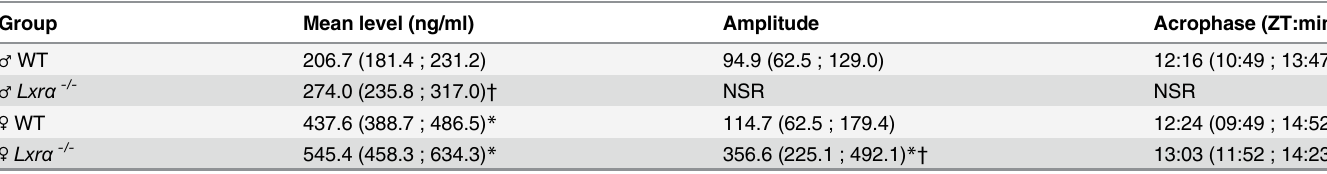
For each parameter measured, values are represented as median ± 95% bootstrap con fi dence intervals. * indicates signi fi cant differences between females vs males † indicates signi fi cant differences between Lxr α -/- vs WT